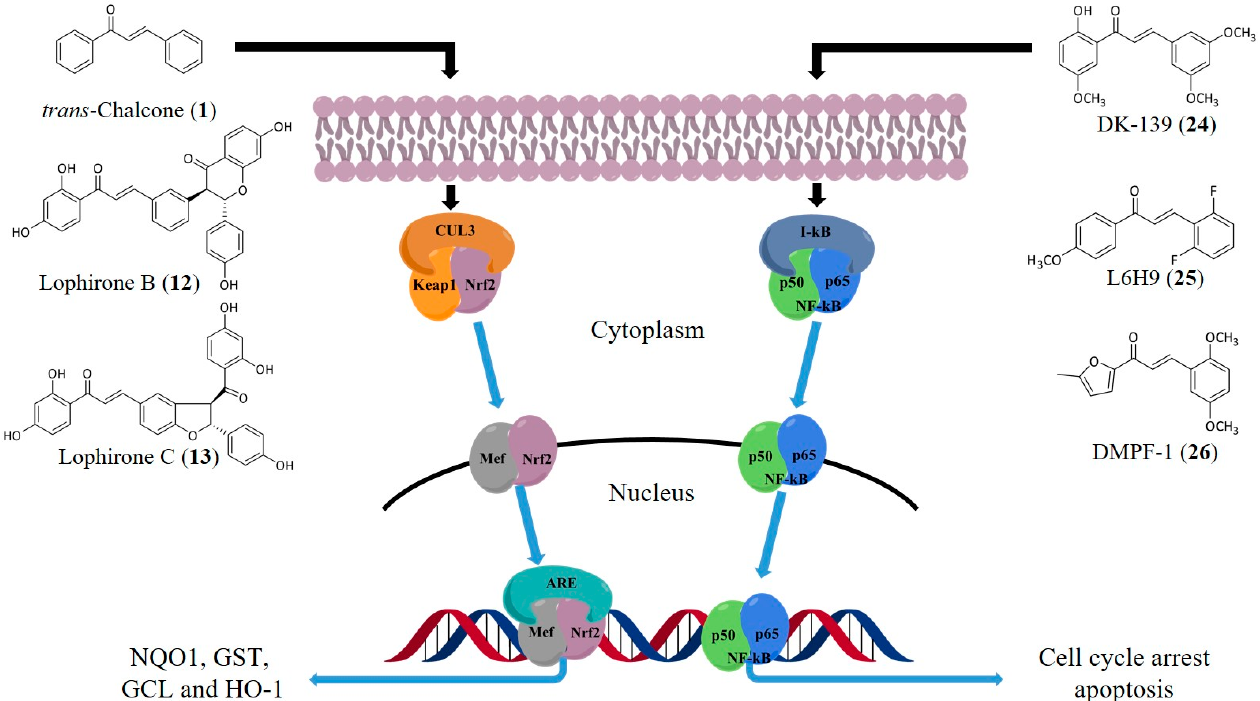
Figure 3. Chalcones that induce transcription factors: chalcone ( 1 ), lophirone B ( 12 ) and C ( 13 ) induce the Nrf2 pathway, while synthetic chalcones DK-139 ( 24 ), L6H9 ( 25 ) and DMPF-1 ( 26 ) induce the NF- κ B pathway.